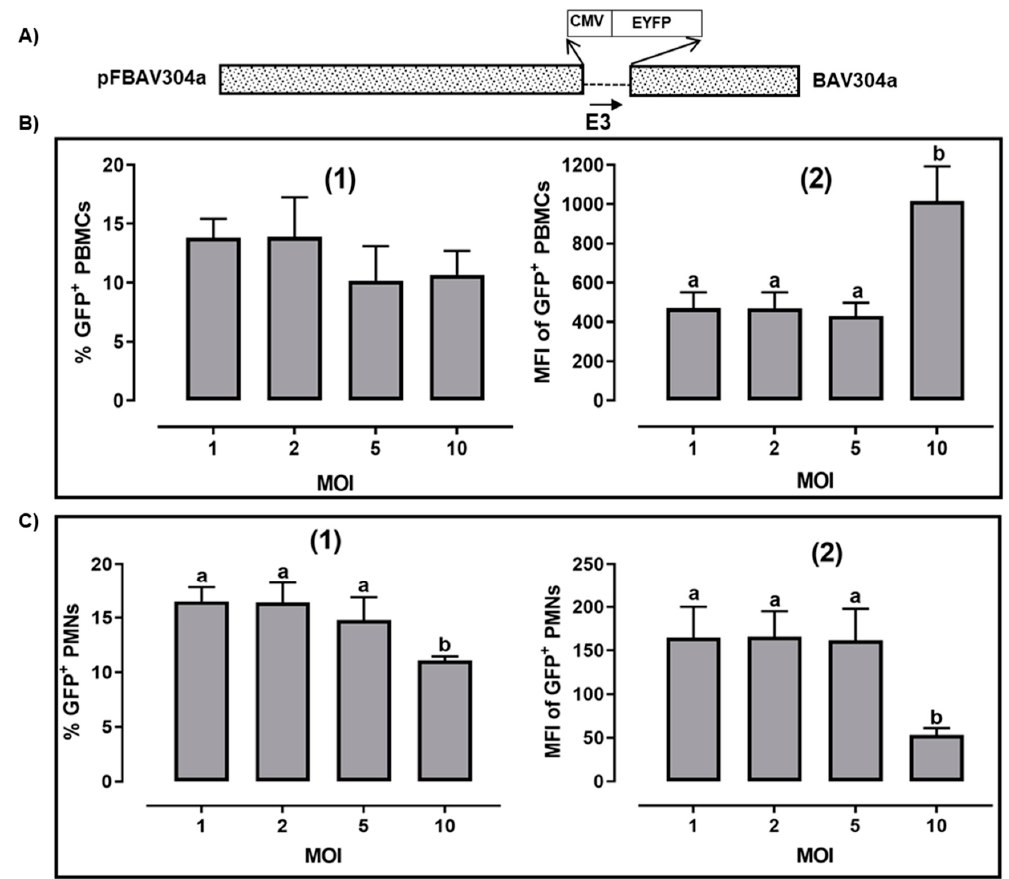
Figure 1. Transduction of bovine cells by BAV304a. ( A ) Schematic diagram of BAV304a genome. Human cytomegalovirus immediate early gene promoter (CMV) and enhanced yellow fluorescent protein gene (EYFP) were inserted in Early (E)-3 region. The direction of transcription is shown by an arrow. Dashed line represents deleted region. The name of the plasmid is on the left and name of the virus is indicated on the right. Purified bovine peripheral blood mononuclear cells (PBMCs) ( B ) or purified bovine PMNs ( C ) were infected with increasing MOI of CsCl purified BAV304a. At 18 h post infection, the cells were collected and analyzed to quantify the percentage of cells expressing EYFP (subpanel 1) and the mean florescent intensity (MFI) of EYFP expression in transduced cells (subpanel 2).